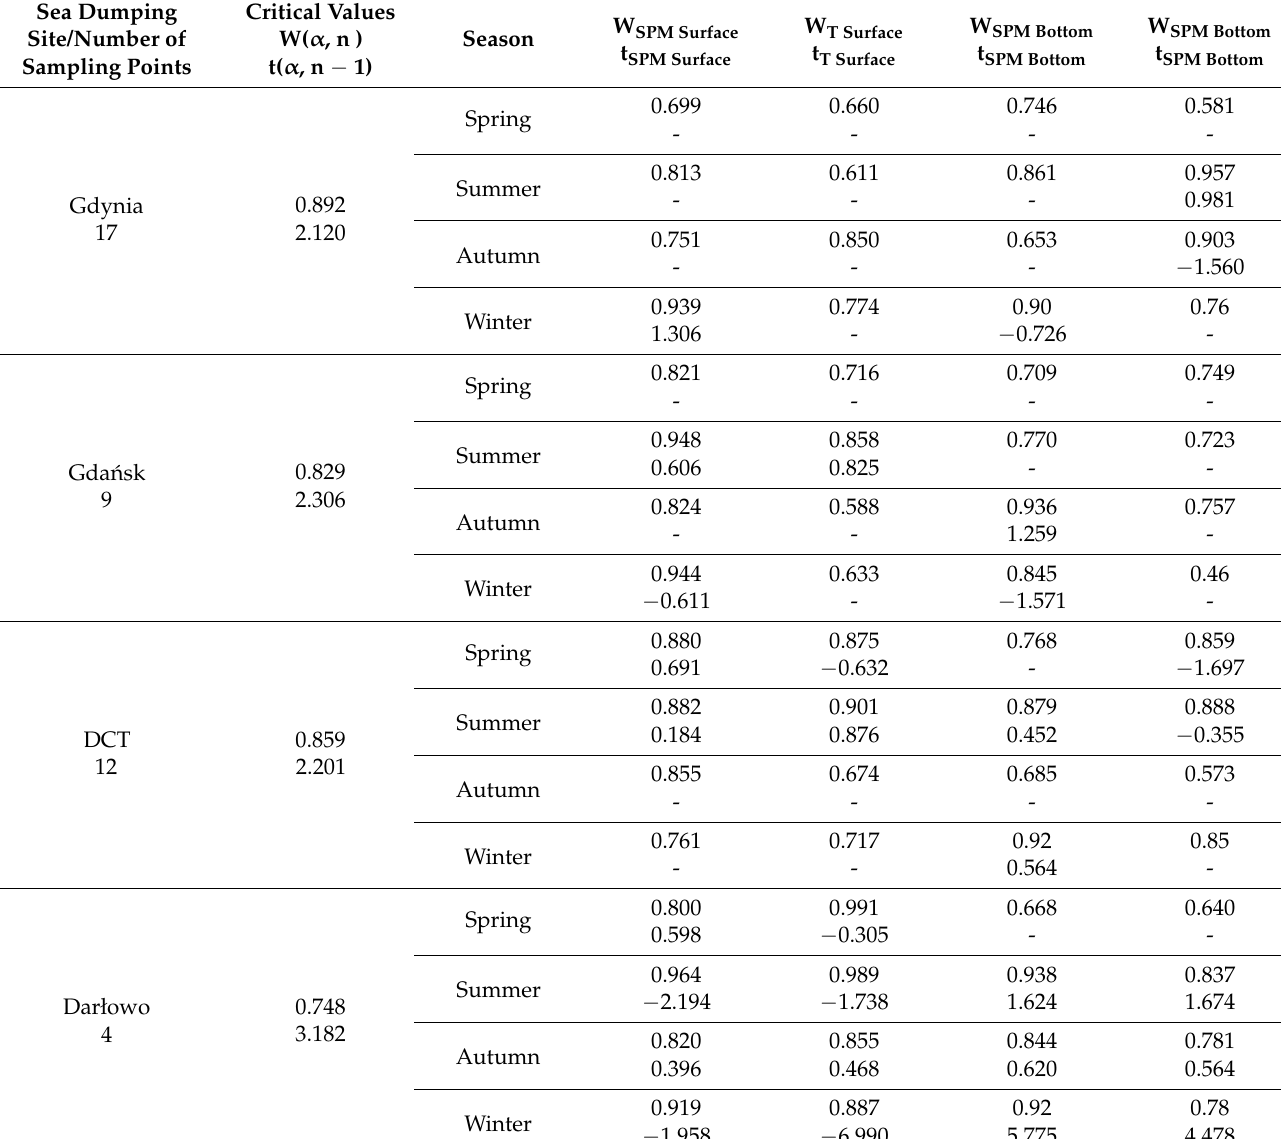
Table 5. Shapiro–Wilk test and t -test results. W values higher than the critical value mean that the distribution of the SPM and turbidity is normal. For these cases, the t -test is applied. The results of a t -test test the hypothesis of whether there are significant differences between the values at the reference points and the other measurement points. Values lower than the critical value, t( α , n − 1), mean no significant